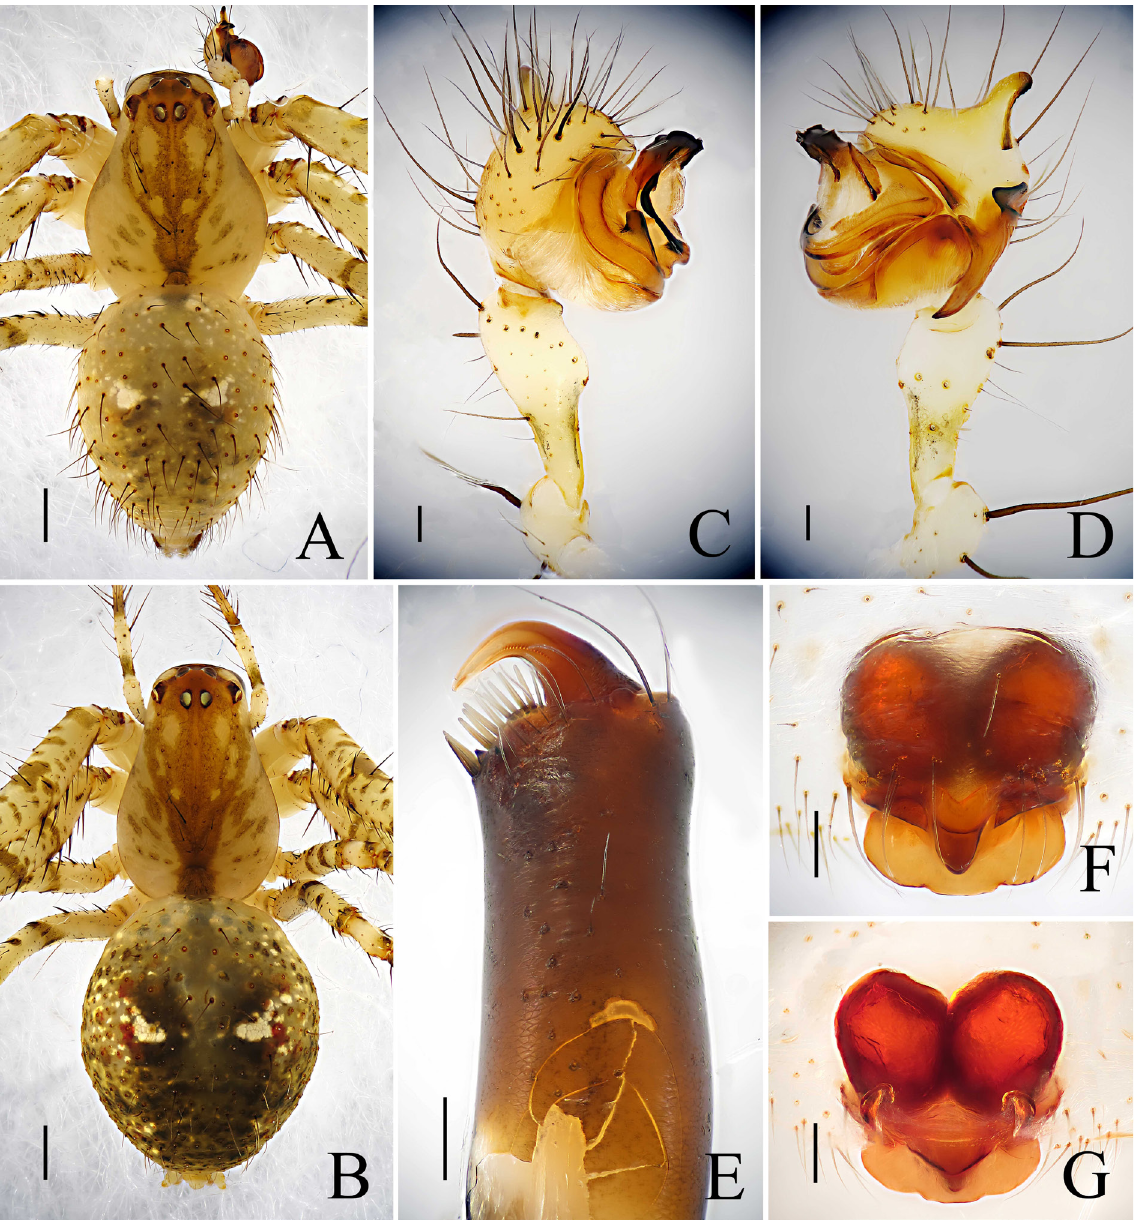
Fig. 3. Mimetus lingbaoshanensis sp. nov. A , C – E . Holotype, ♂ (YN-MIM-2015-010). B , F – G . One of the paratypes, ♀ (YN-MIM-2015-011). A – B . Habitus, dorsal view. C . Palp, prolateral view. D . Palp, retrolateral view. E . Left chelicerae, ventral view. F . Epigyne, ventral view. G . Vulva, dorsal view. Scale bars: A–B = 0.5 mm; C–G = 0.1